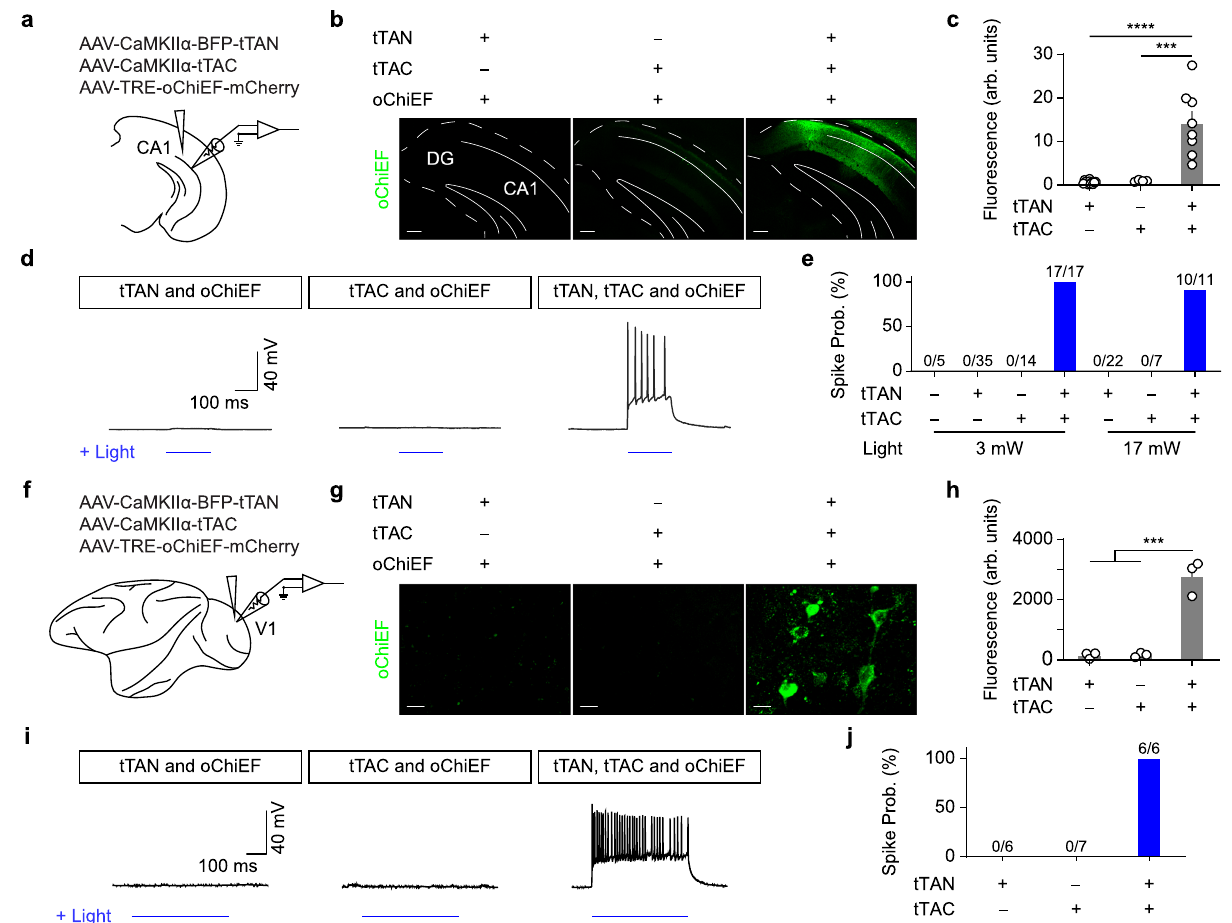
Fig. 2 The IBIST-based optogenetic excitation. a Scheme depicting AAV injections into hippocampus. b , Examples showing mCherry fl uorescence (shown in green) in hippocampus injected with AAV-TRE-oChiEF and AAVs (CaMKII α promoter) of tTAN, tTAC or both, respectively. Scale bars: 200 µ m. c Summary of fl uorescent intensity in b . One-way ANOVA between groups ( F (2,21) = 25.26, **** P = 2.58 × 10 − 6 ). Turkey ’ s multiple comparisons revealed that the fl uorescence is signi fi cantly higher in tTAN + tTAC group (tTAN vs. tTAN + tTAC, **** P = 3.07 × 10 − 6 ; tTAC vs. tTAN + tTAC, *** P = 0.0002). tTAN, N = 3 animals; tTAC, N = 1 animal; tTAN + tTAC, N = 2 animals. d Examples showing whole-cell current-clamp recording from hippocampal cells in brain slices with blue LED light stimulation (blue line). All animals were injected with AAV-TRE-oChiEF and co-injected with AAVs (CaMKII α promoter) of either tTAN, tTAC or both. e Summary of spike probabilities (prob.) in hippocampal cells evoked by whole- fi eld blue LED light (3 mW or 17 mW) from animals injected with AAV-TRE-oChiEF and other CaMKII α -speci fi c AAVs: none, N = 1 animal; tTAN, N = 6 animals; tTAC, N = 2 animals; tTAN + tTAC, N = 4 animals. The recordings were from local neurons at the injected site. f Scheme depicting AAV injections into V1 of Macaca fascicularis . g , Examples showing mCherry fl uorescence (shown in green) in V1 after injected with AAV-TRE-oChiEF-mCherry and CaMKII α -speci fi c AAVs of tTAN, tTAC or both. Scale bars: 10 µ m. h , Summary of fl uorescent intensity in g . Each group consists of brain slices obtained from corresponding injection site ( n = 3 FOV/ group). One-way ANOVA between groups (F (2,6) = 58.19, *** P = 0.0001) and Turkey ’ s multiple comparisons revealed that the fl uorescence is signi fi cantly higher in tTAN + tTAC group (*** P < 0.001 for all). i Examples showing whole-cell current-clamp recording in brain slices with blue LED light stimulation (blue line). All groups were injected with AAV-TRE-oChiEF and co-injected with CaMKII α -speci fi c AAVs of either tTAN and tTAC, or both. j Summary of spike probabilities evoked by whole- fi eld blue LED light (3 mW) from animals injected with AAV-TRE-oChiEF and other AAVs. Data summary: mean ± SEM. Statistical tests: two sided. Source data are provided as a Source Data fi from injections (Supplementary Fig. 5k). These results demon- promoter-based viral labeling. We engineered tTAN-expressing rabies vectors and speci fi cally labeled vCA1-projecting dCA3 neurons with TRE reporter (Supplementary Fig. 5g – i). We con- tinued to test whether IBIST tools are able to combine features of both anterograde and retrograde connections. The nucleus of reunien (RE) is known to be a critical relay to transfer informa- tion from the medial prefrontal cortex (mPFC) to the hippocampus 38 . By local injections of anterograde AAV1-EF1 α - tTAN into mPFC, retrograde AAVretro-CaMKII α -tTAC into vCA1 and AAV-TRE-oChiEF-mCherry into RE respectively, we speci fi cally labeled RE cells with direct inputs from mPFC and direct outputs to vCA1 (Supplementary Fig. 5j and k). No cells were labeled if either tTAN or tTAC component was omitted in vCA1 while animals underwent open fi eld test (Fig. 4d, e and